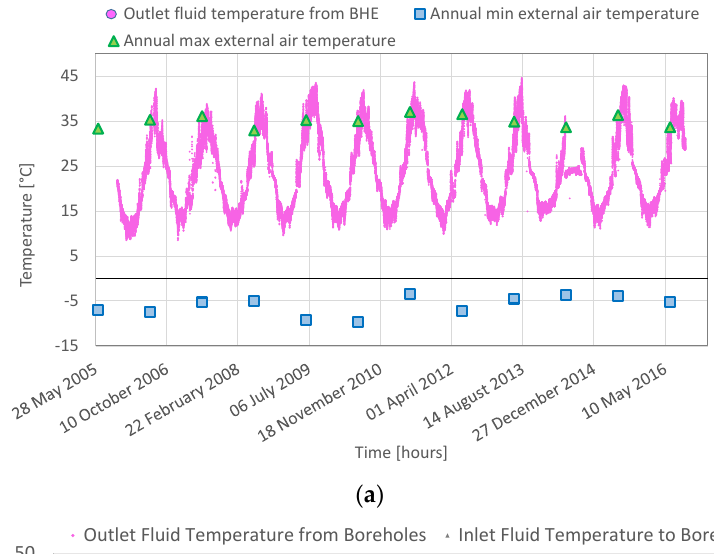
Figure 2. Case study: ( a ) building, ( b ) layout of the installed boreholes, ( c ) new heat pump, ( d ) air ‐ condenser.